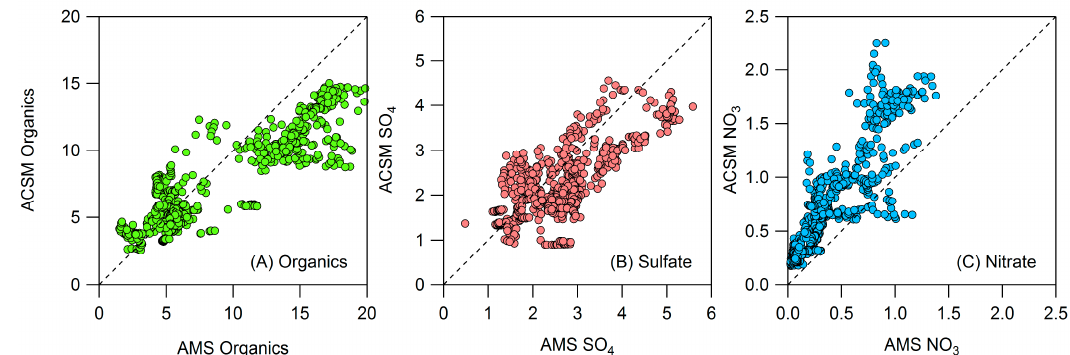
Figure A3. ACSM and HR-ToF-AMS comparison of (A) organics, (B) sulfate, and (C) nitrate. HR-ToF-AMS measurements are high resolution while ACSM measurements are unit mass resolution.